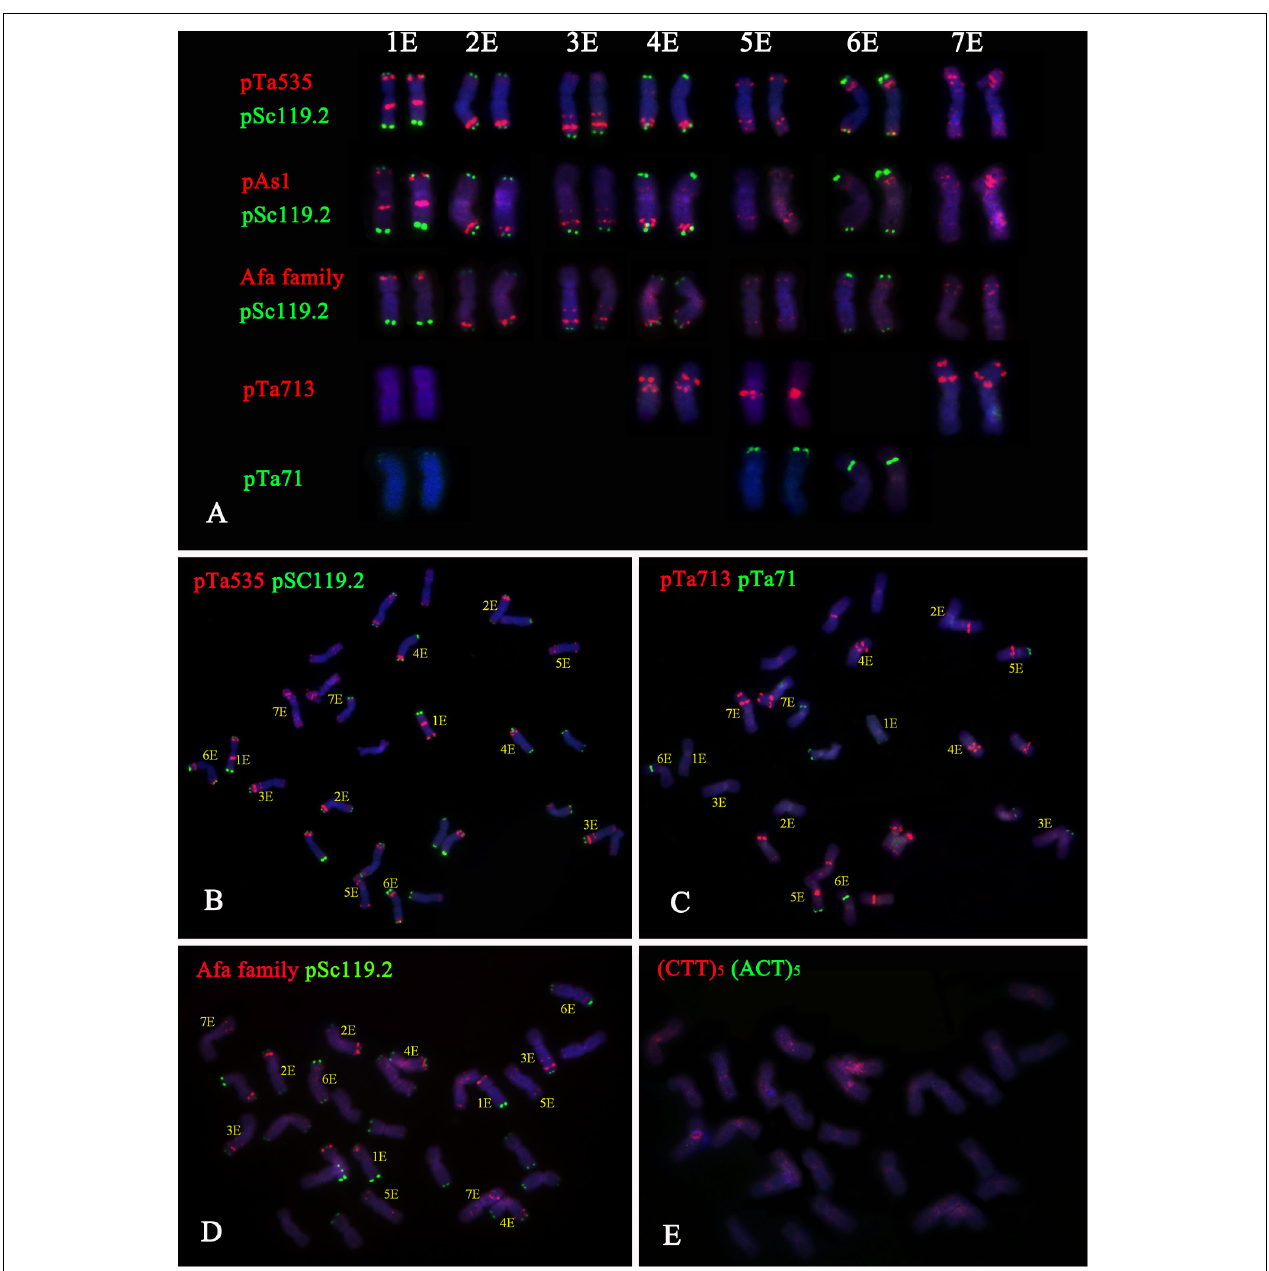
FIGURE 3 | FISH patterns of the tetraploid Th. elongatum . (A) FISH patterns of the 1E-7E chromosomes using pSc119.2 (green), pTa535 (red), Afa family (red), pAs1 (red), pTa713 (red), and pTa71 (green). (B) FISH identification of PI531750 using pTa535 (red) and pSc119.2 (green). (C) FISH identification of PI531750 using pTa713 (red) and pTa71 (green). (D) FISH identification of PI531749 using Afa family (red) and pSc119.2 (green). (E) FISH identification of PI531749 using (ACT) 5 and (CTT) 5 . The probes (ACT) 5 and (CTT) 5 failed to show any signals on the E-genome